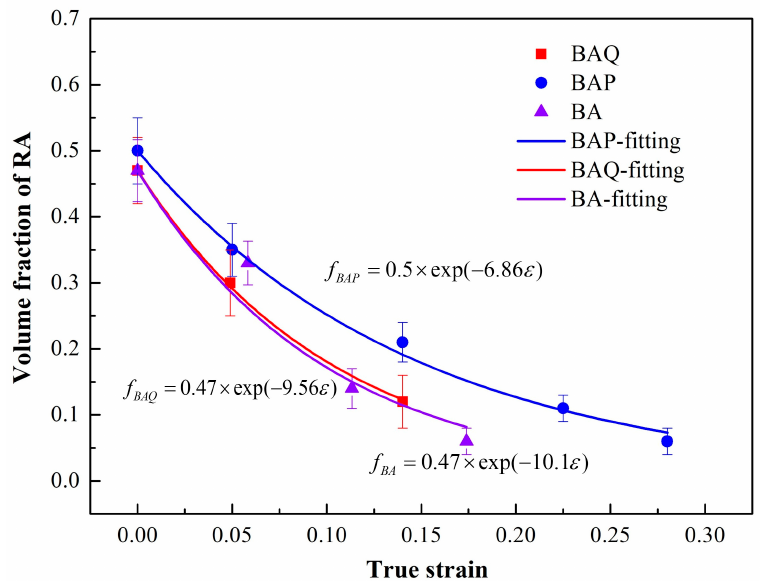
Figure 4. The volume fraction of RA at different strains corresponding with the calculated fitting curves.